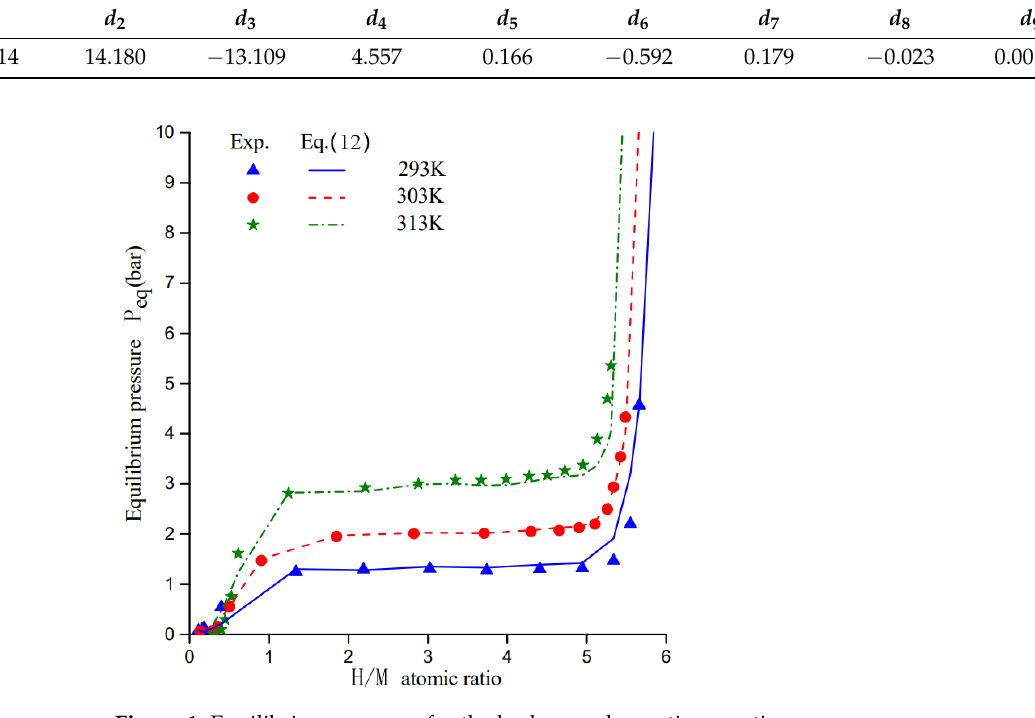
Figure 1. Equilibrium pressure for the hydrogen desorption reaction.